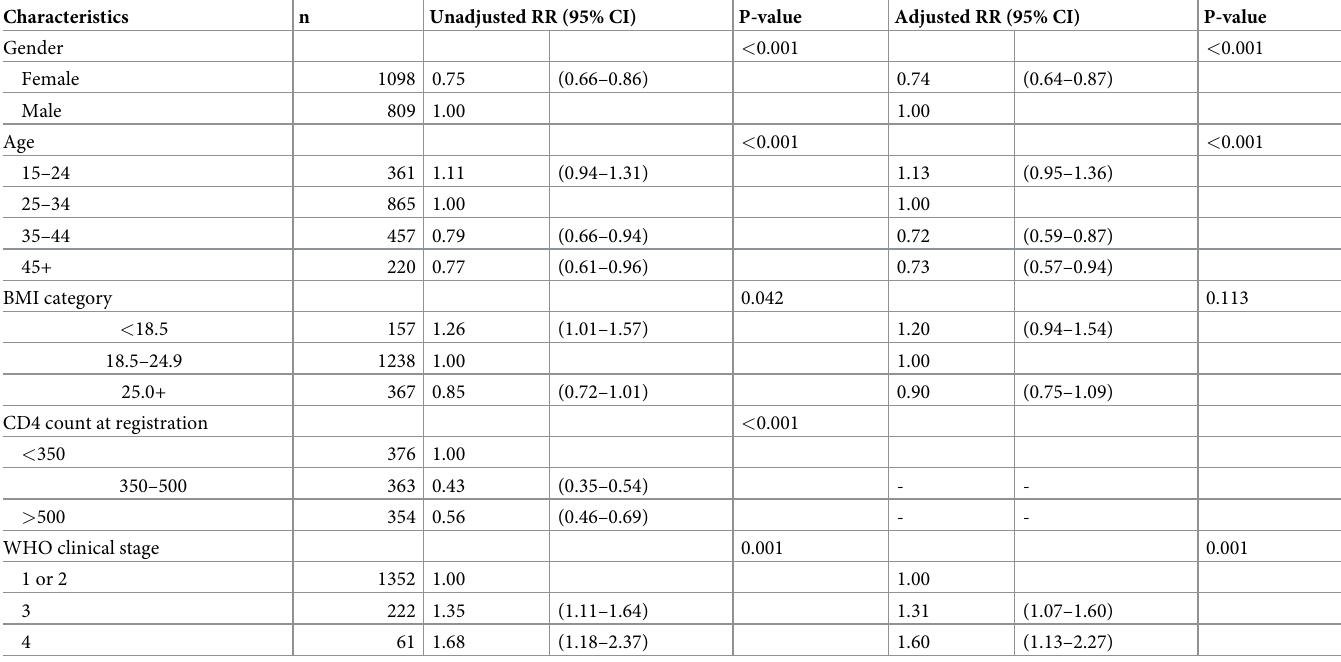
Table 3. Univariable and multivariable model of characteristics associated with loss to follow-up from pre-ART care in Lilongwe, Malawi.